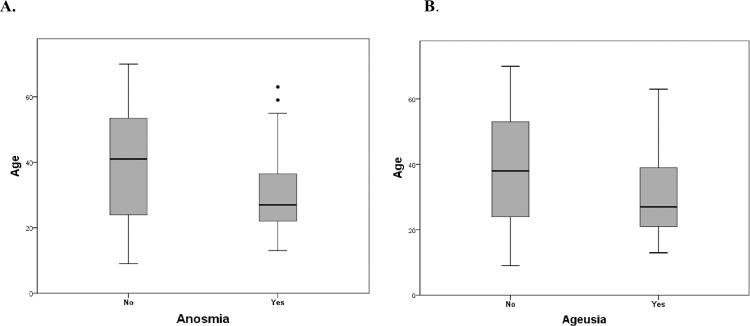
Distribution of age according to patients without or with symptoms.A. Patients with anosmia (n = 47), B. Patients with ageusia (n = 37).